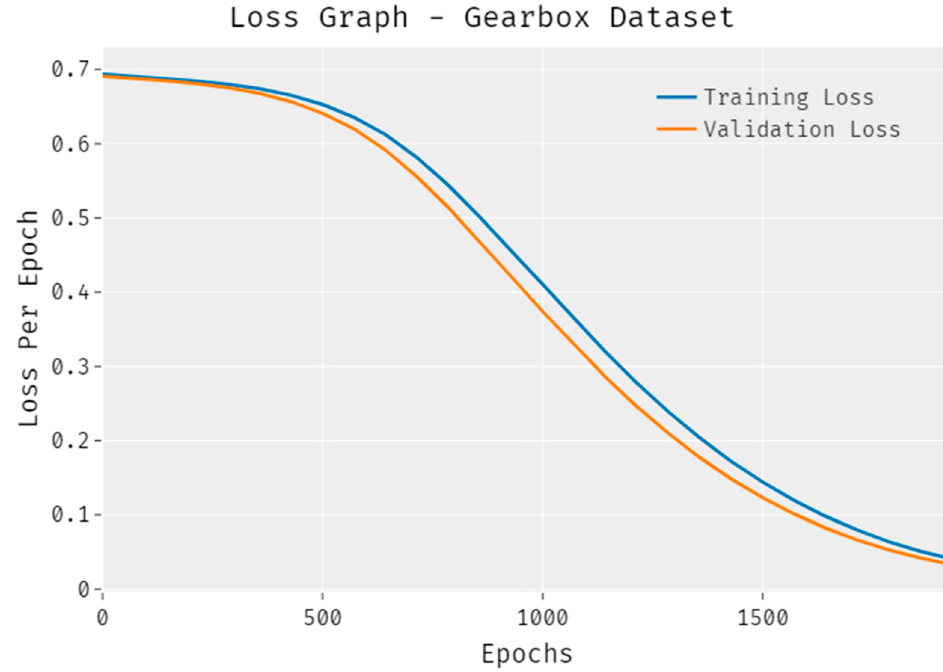
Figure 5. Loss analysis results of SPOAI-FD technique under Gearbox dataset.